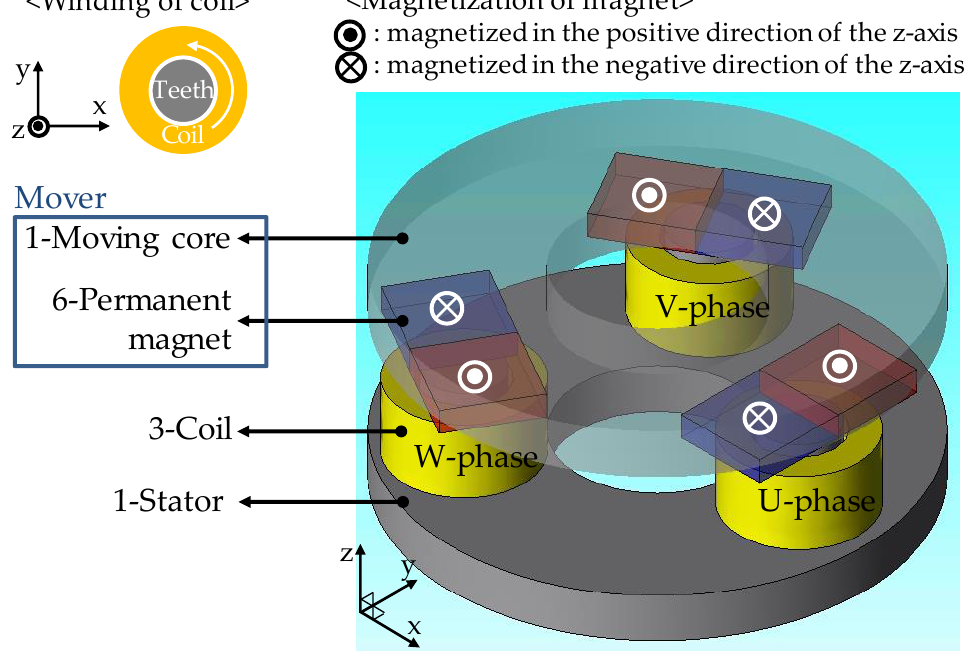
Figure 1. Structure of the proposed two-degree-of-freedom linear resonant actuator (2-DOF LRA).